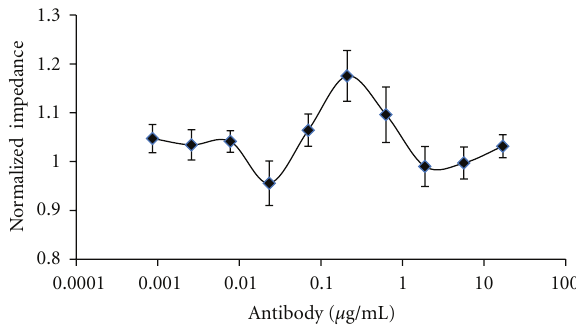
Figure 3: Determination of optimal coating concentration for pyrene-hydrazide labeled E. coli O157:H7 polyclonal antibody. CNT-FET circuits were coated with labeled antibody as described in Section 2 followed by addition of 10 μ L of 10 7 cfu/mL E. coli O157:H7 in diH 2 O. Impedance was measured for 4 minutes after addition of the bacteria and plotted as the normalized impedance compared to baseline value of the individual circuit. Each point represents at least 5 measurements with standard error of the